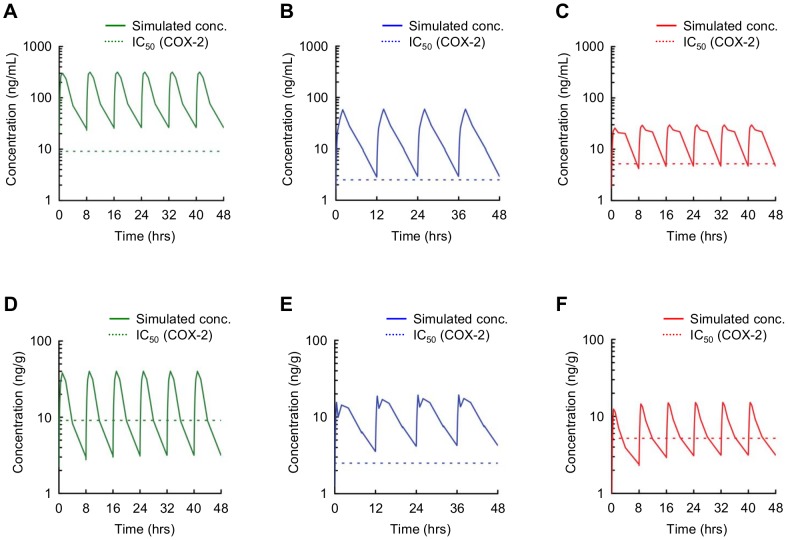
The simulated drug concentrations in aqueous humor and retina/choroid with the IC50 for COX-2.The pharmacokinetic profiles of diclofenac (A) and amfenac (C) in the aqueous humor were calculated on the basis of a three/day dosing at an interval of eight hours, and the profile of bromfenac (B) was calculated on the basis of a two/day dosing at an interval of twelve hours. The retinochoroidal pharmacokinetic profiles of diclofenac (D), bromfenac (E) and amfenac (F) were also calculated in the same manner. The simulated concentrations (solid line) of diclofenac (A) and bromfenac (B) in the aqueous humor were higher than their corresponding IC50 values of the NSAIDs for COX-2 (dotted line). The concentrations of amfenac (C) were almost always higher than the IC50 of COX-2 although it was slightly less than the IC50 at the trough level. In retinochoroidal tissues, the simulated concentration of bromfenac (E) with a two/day dosing was higher than the IC50 value for COX-2, whereas the concentrations of diclofenac (D) and amfenac (F) with a three/day dosing were lower than the corresponding IC50 values at the troughs. Each value of the IC50 for COX-2 indicated in the figures is referred in Table 1.